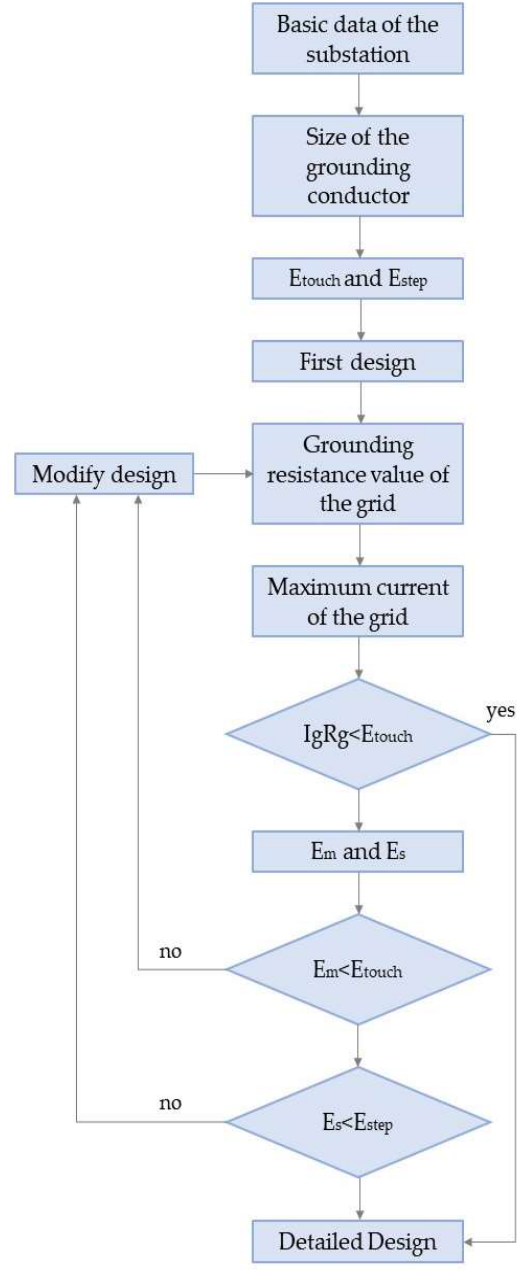
Figure 2. Grounding resistance design flow.